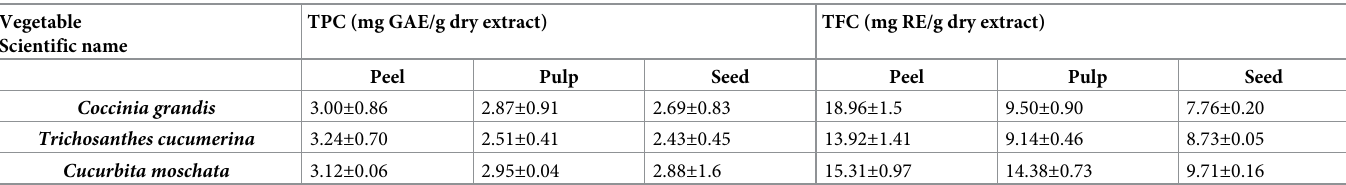
Table 2. TPC and TFC in the aqueous extracts of various parts of studied Cucurbitaceae vegetables. Vegetable Scientific name